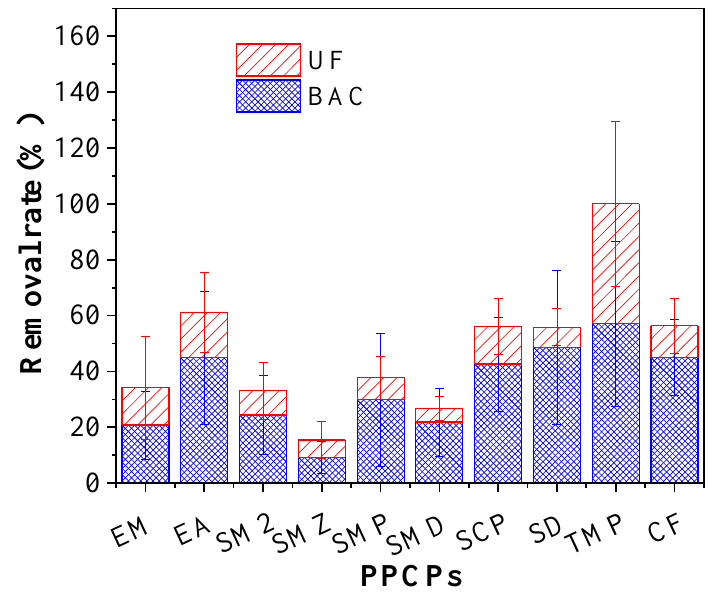
Figure 6. Typical antibiotics removal contribution by BAC and UF.